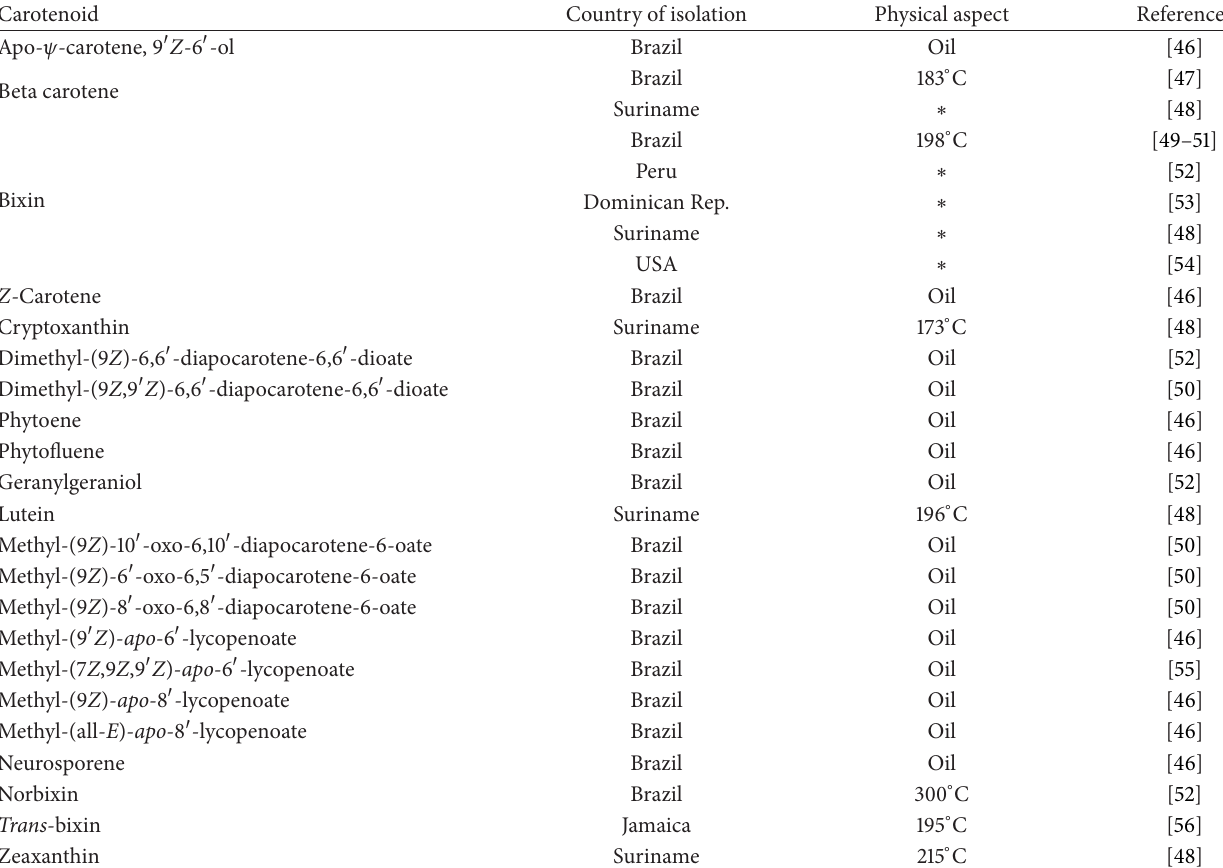
Table 2: The main carotenoids from the seeds of Bixa orellana